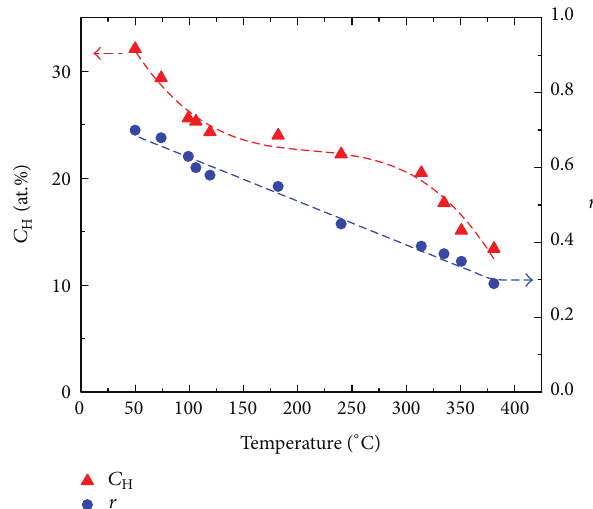
Figure 9: 𝐶 and 𝑟 as functions of temperature. The 𝐶 H a gradual reduction with a plain over a large span of temperature, resulting in good lifetime with a wide process window. The lines are guides for the eye.